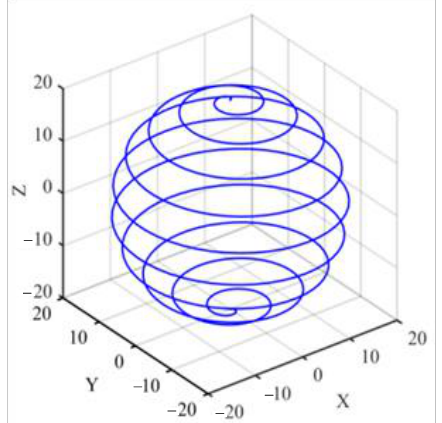
Figure 10. Spatial tracking path.